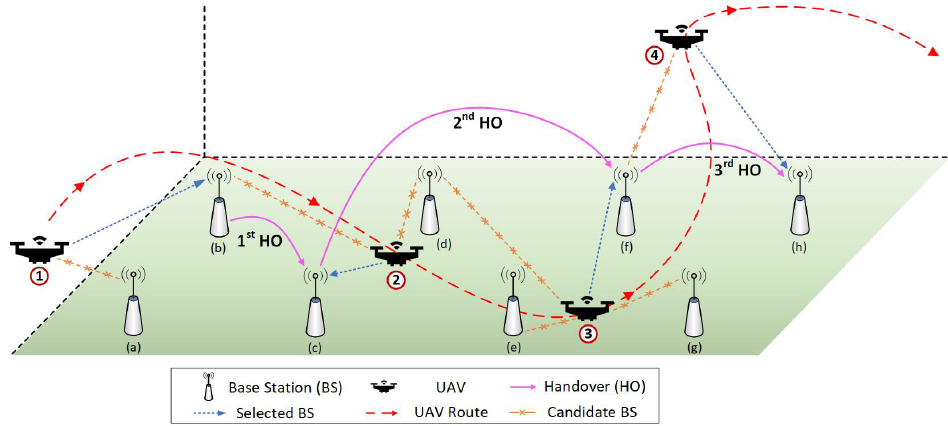
Figure 3. Operational explanation of a UHD with example handovers during a UAV